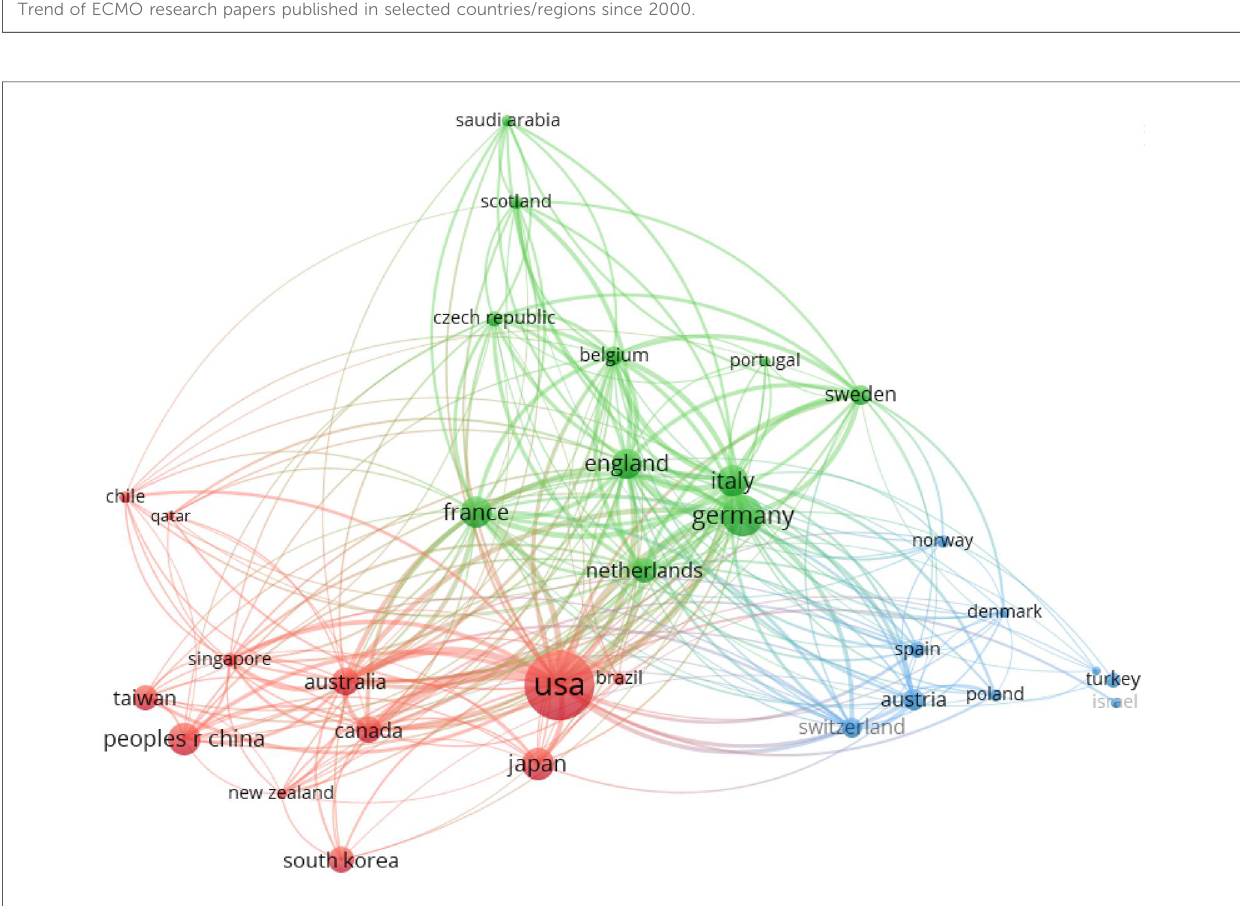
FIGURE 5 Cooperation network in the fi eld of ECMO